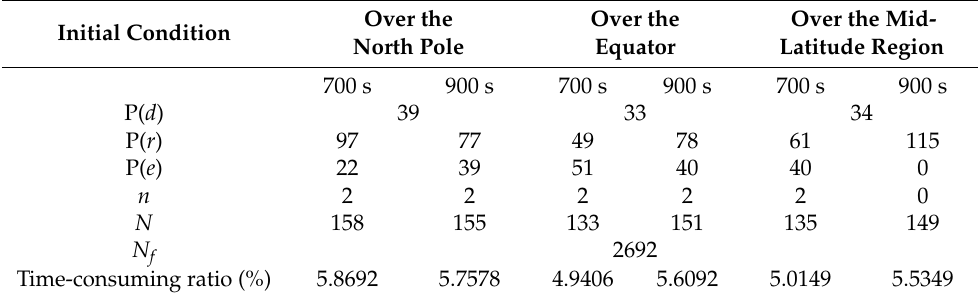
Table 1. Time-consuming